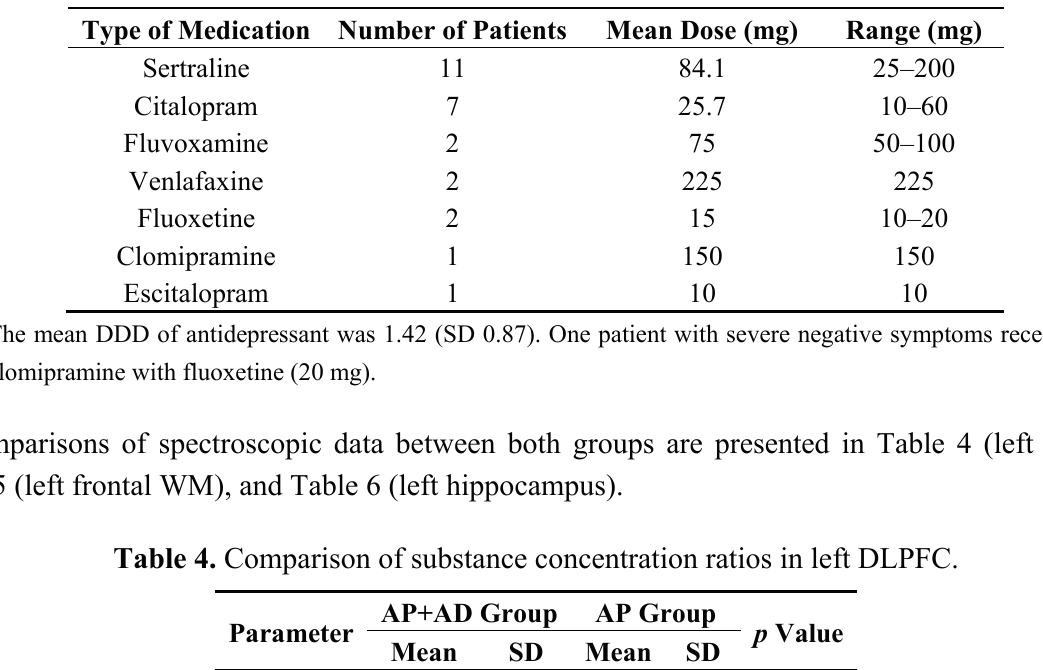
Table 3. Description of antidepressive therapy.